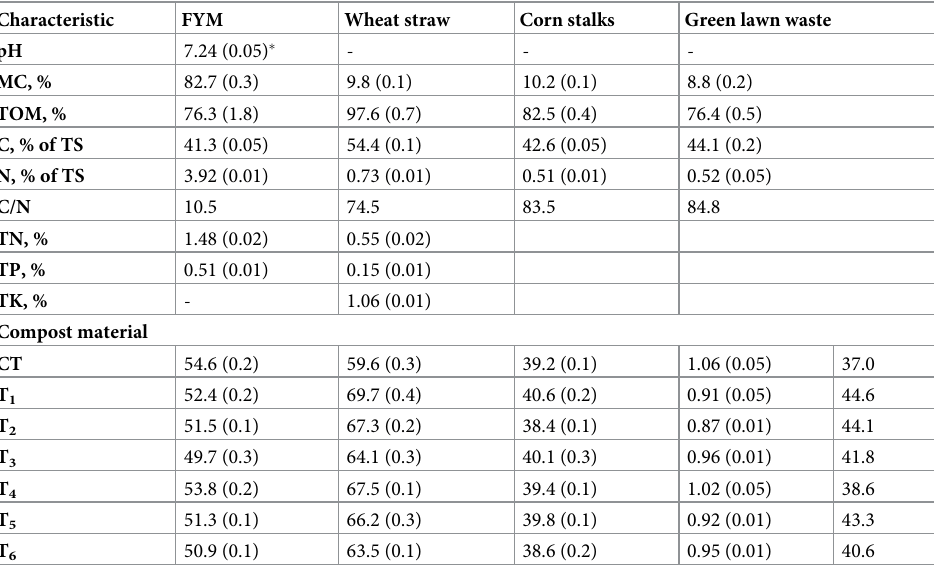
Table 2. Examining the characteristics of feedstock material.